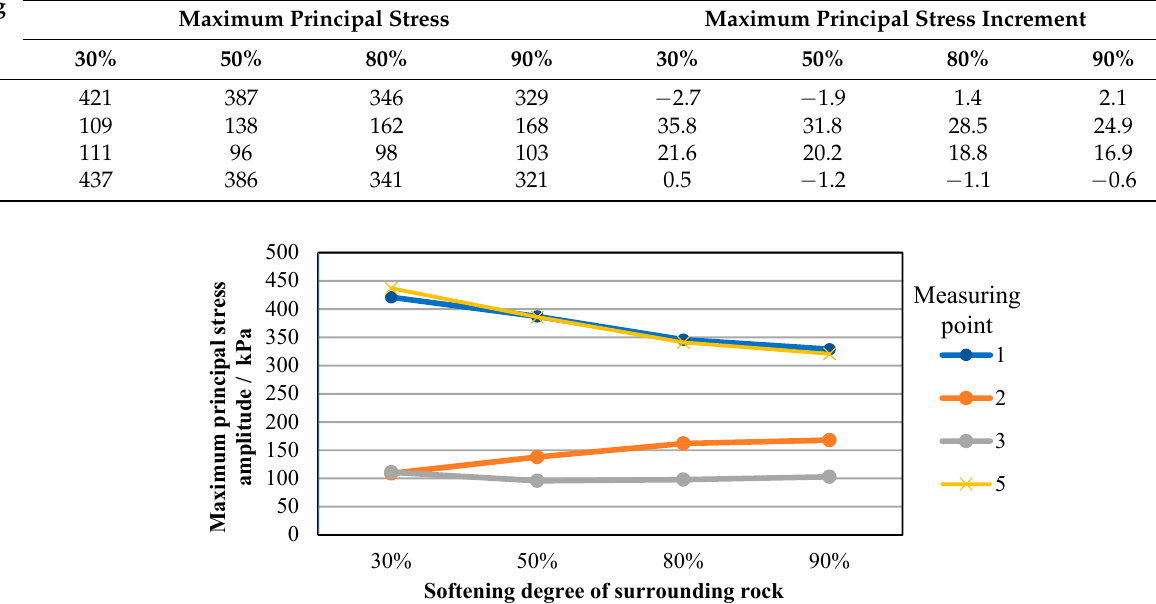
Table 12. Horizontal dynamic stress amplitudes of measuring points 2, 3, and 4 under different degrees of damage to the foundation structure.